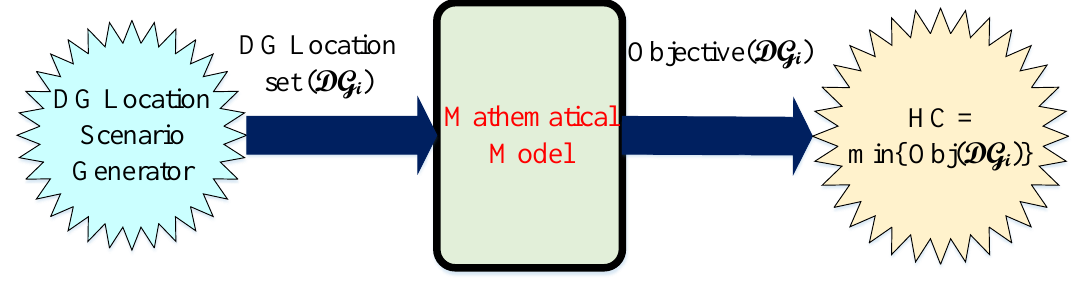
Figure 1. The HC calculation